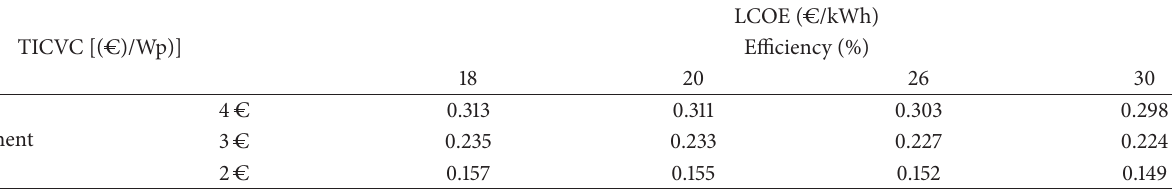
Table 3: Calculated LCOE, in C/kWh for different total investment cost and PV efficiency.